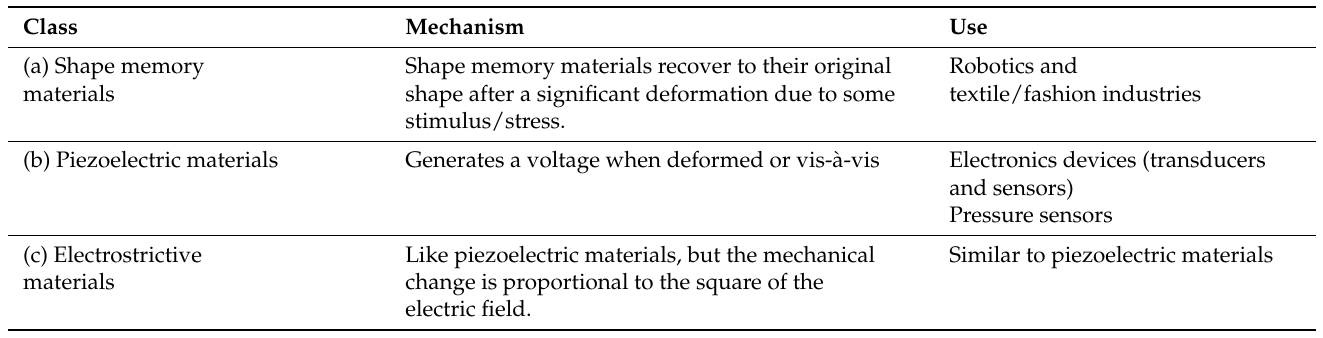
Table 1. Classification, Mechanism and Use of Smart